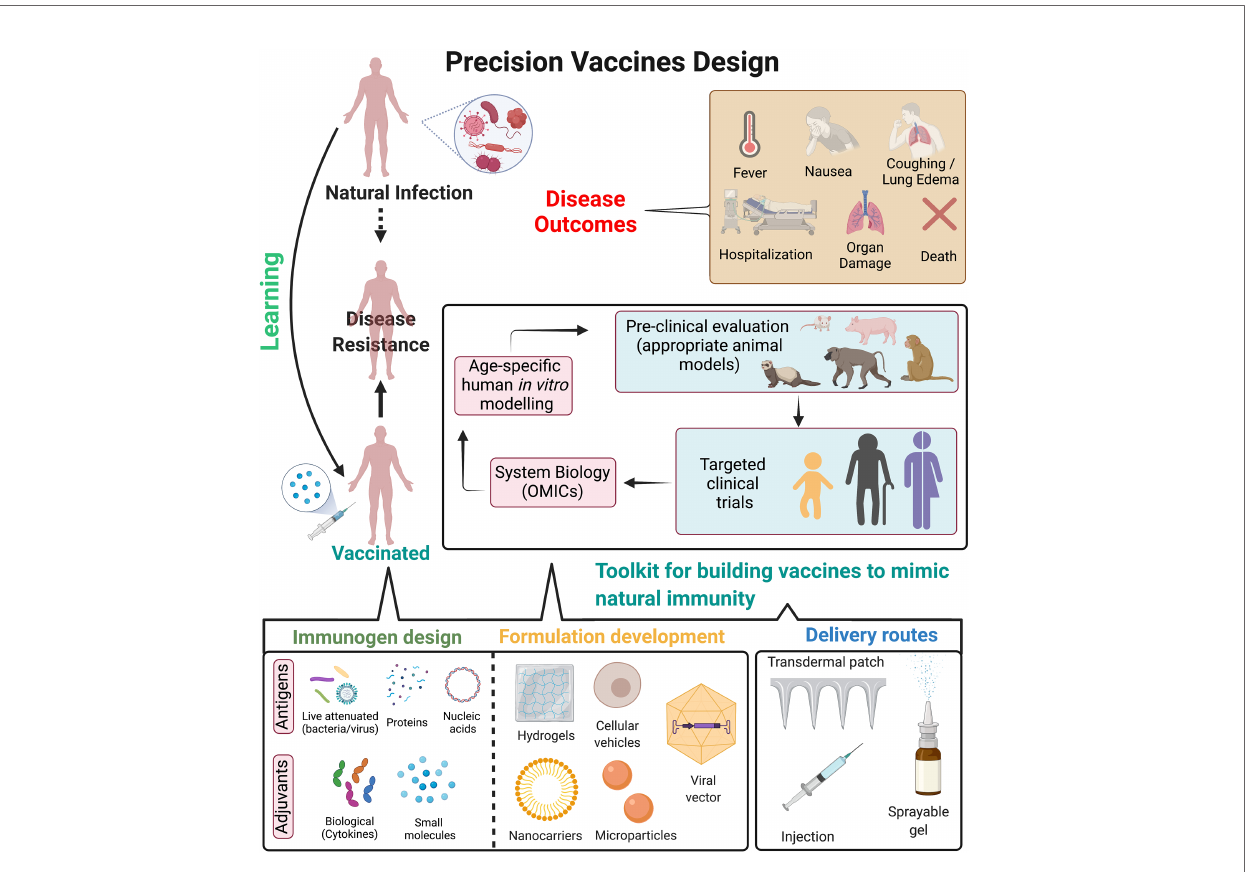
FIGURE 2 | Precision vaccines design. Overview of strategies to design precision vaccines which can effectively mimic immunity against pathogens as observed post natural infection. Natural infection often leads to immunological imprinting which provides long-term immunity and disease resistance to future exposure of pathogens. However, it can also lead to detrimental effects to the host as observed in disease outcomes. On the contrary, vaccination provides disease resistance but may be associated with waning immunity, insuf fi cient protective immune response either in vulnerable populations or to prevent disease transmission, contraindications for immunocompromised hosts etc. Precision vaccines can guide the development of next generation vaccines by incorporating a toolkit for building vaccines to mimic natural immunity, which includes: i) immunogen design (such as antigens, small molecule TLR or other adjuvants, biological adjuvants such as cytokines); ii) optimizing formulations for targeted delivery to antigen presenting cells which can lead to subsequent long-lasting adaptive immune response (approaches such as hydrogels, cellular vehicles, nanocarriers and microparticles etc.); iii) optimizing delivery routes for enhancing immune response and mimicking the natural exposure to the pathogen (such as transdermal patch, injection site, sprayable gels for nasal routes) and iv) pre-clinical evaluation of vaccine formulations in appropriate animal models can be followed by clinical evaluation in distinct populations. System biology approaches from such clinical trials may be helpful to dissect age- and population speci fi c vaccine-induced cellular and molecular signatures which correlate with protective immunity. Further, usage of human in vitro modelling may accelerate and/or expand hypothesis testing and selection of population speci fi c adjuvants. These approaches can lead to precision vaccines tailored for long-term disease protection while abating disease outcomes associated with natural infection. Figure is created with